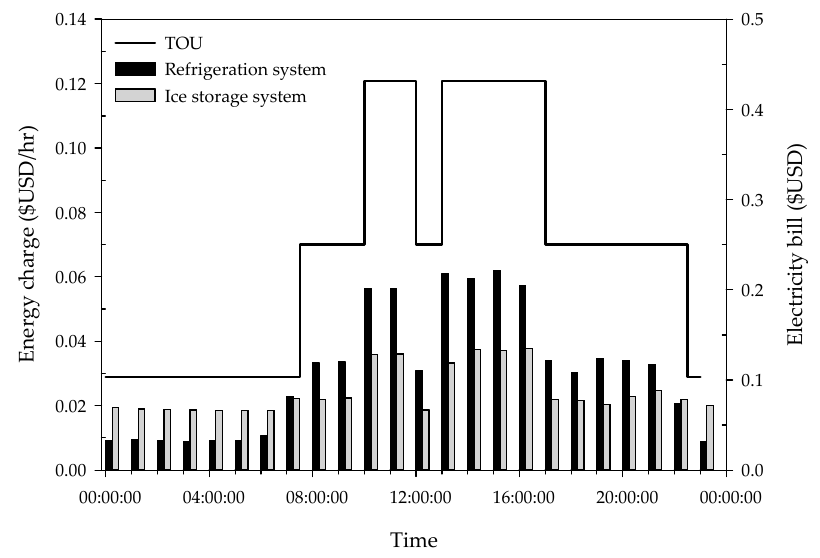
Figure 11. Comparison between the energy charge of the two systems. To evaluate the benefits of the energy saving, the authors inspected the pressure– enthalpy diagram of the operation modes in the ice storage system through COP compari- son. The corresponding pressure–enthalpy diagram is schematically presented in Figure 12. Various parameters were also considered. The results revealed that the condensing pressure and temperature in the melting mode were significantly lower than those in the refrig- eration mode. The condensing pressure is greatly reduced from 1556 kPa to 801.8 kPa, which reduced the enthalpy difference at the inlet/outlet of the compressor between the refrigeration mode (37.9 kJ/kg) and the melting mode (28.5 kJ/kg). The refrigeration capacity is increased (refrigeration mode: 136.4 kJ/kg; melting mode: 181.1 kJ/kg). The COPs of the melting mode and refrigeration mode were approximately 6.35 and 3.6, respec- tively. Accordingly, it is confirmed that the ice storage system can lower the condensing temperature and pressure through melting ice during peak hours, which will effectively increase the efficiency when compared to conventional refrigeration